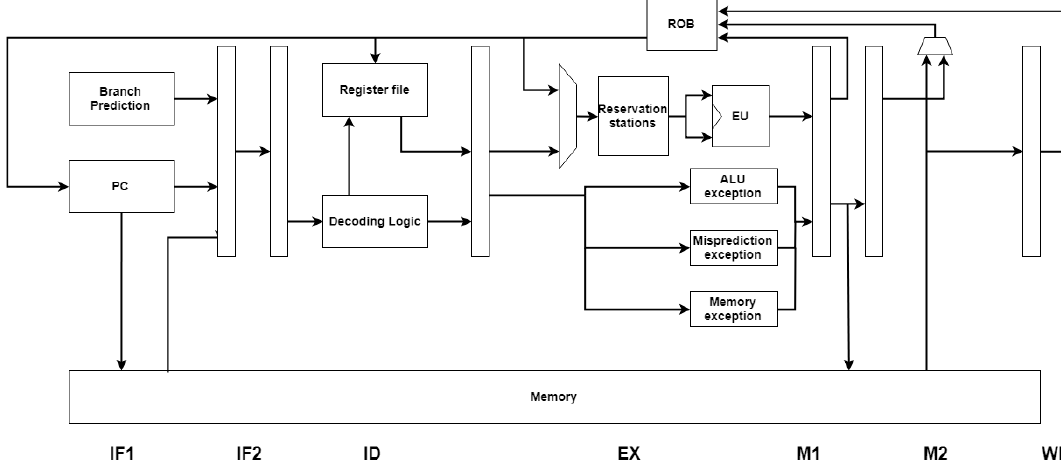
Figure 1. The pipelined processor model with 7 stages: [IF1] A 32-bit instruction is fetched